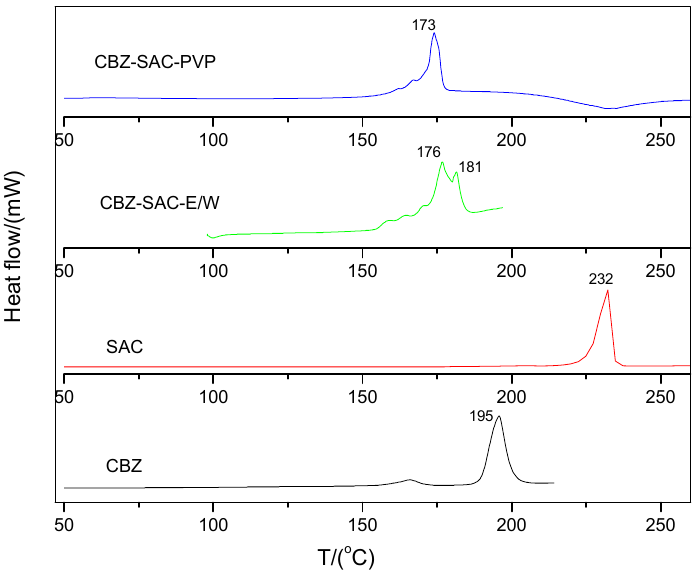
Figure 5. DSC curves of CBZ, SAC, CBZ-SAC-E/W, and CBZ-SAC-PVP.